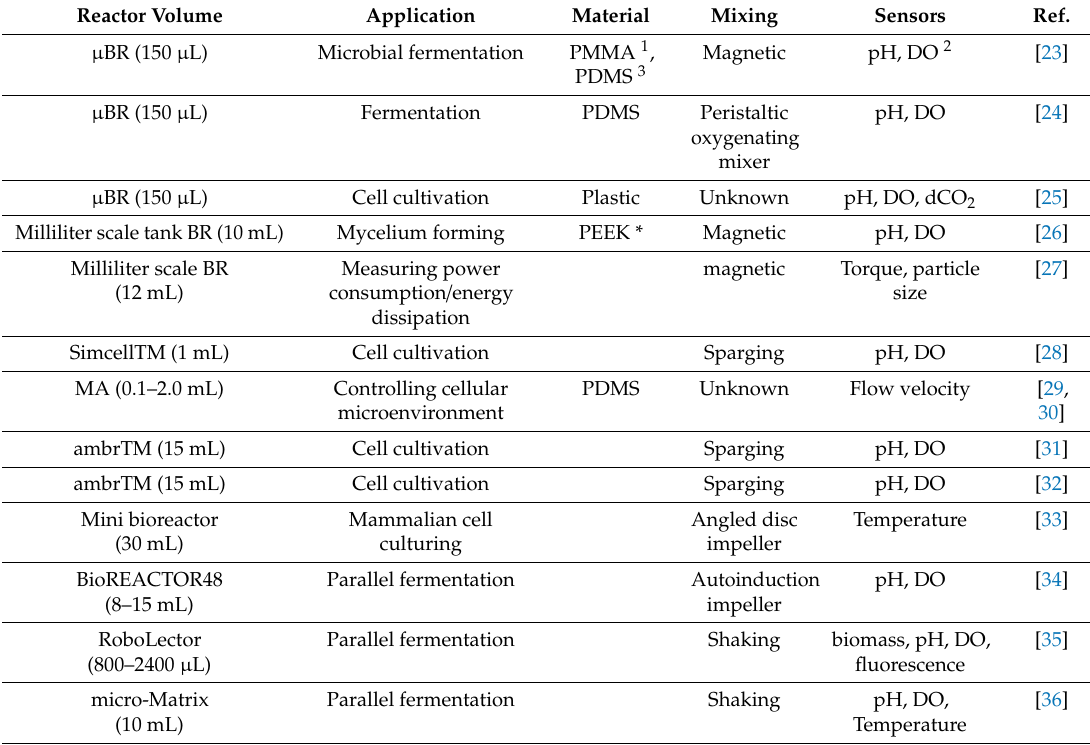
Table 1. Miniature bioreactor systems and their main